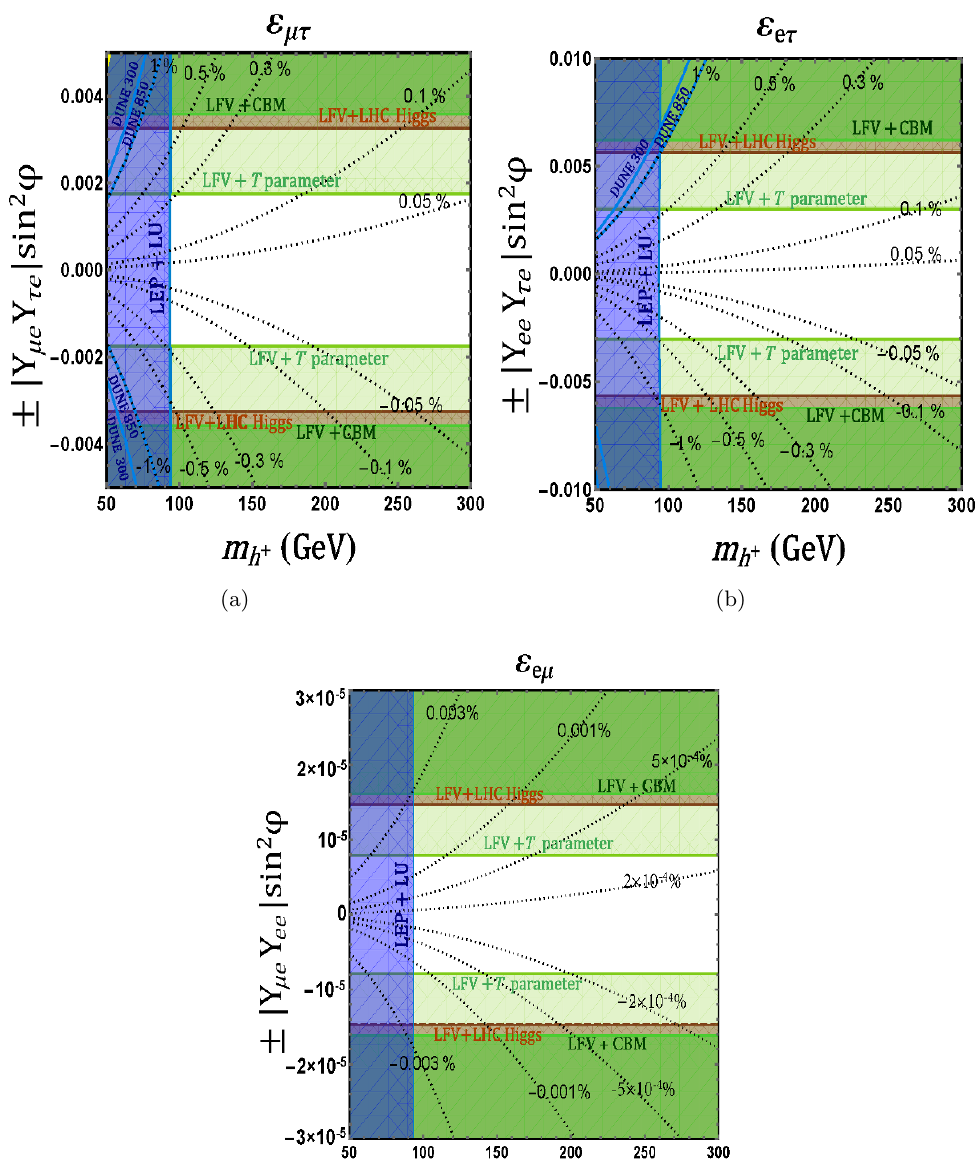
Figure 19 . Zee model predictions for o(cid:11)-diagonal NSI ( " e(cid:22) ; " (cid:22)(cid:28) ; " e(cid:28) ) are shown by black dotted contours. Color-shaded regions are excluded by various theoretical and experimental constraints. Blue-shaded region is excluded by direct searches from LEP and LHC (section 4.7) and/or lepton universality (LU) tests in W decays (section 4.8). Light green, brown and deep green-shaded regions are excluded respectively by T -parameter (section 4.4), precision Higgs data (section 4.10), and charge-breaking minima (section 4.3), each combined with cLFV constraints (section 4.5). The current NSI constraints from neutrino oscillation and scattering experiments are weaker than the cLFV constraints, and do not appear in the shown parameter space. The future DUNE sensitivity is shown by blue solid lines, for both 300 kt.MW.yr and 850 kt.MW.yr exposure [66].